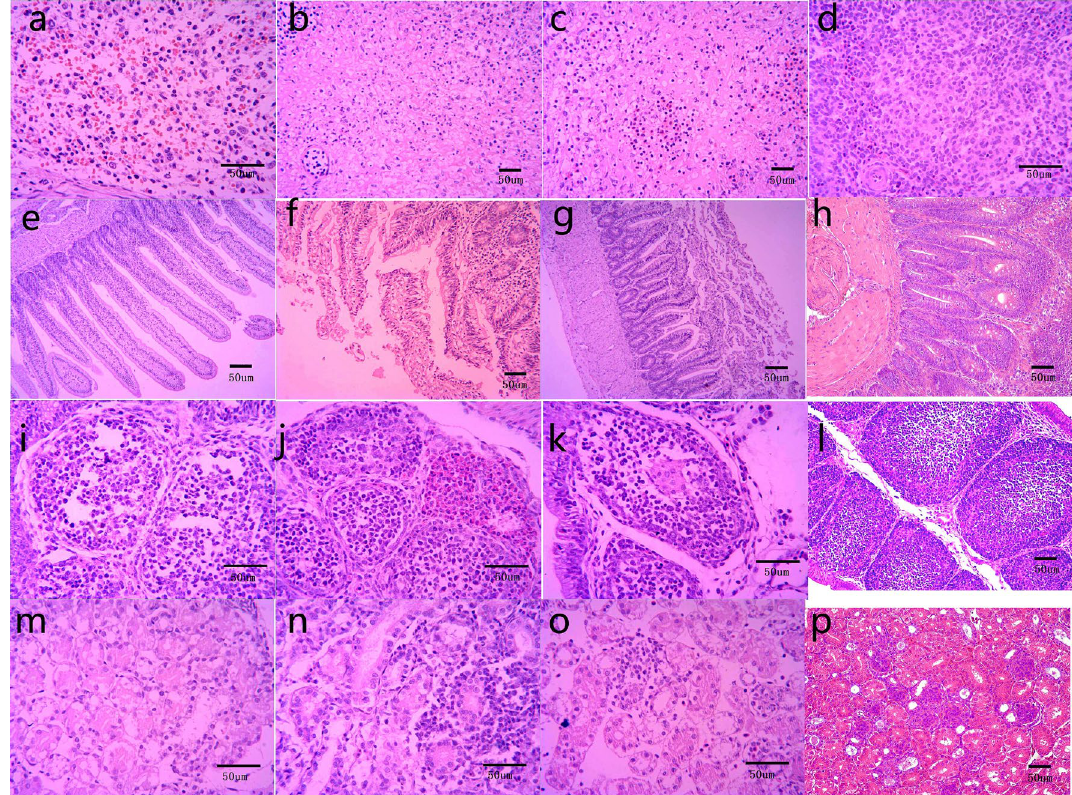
Figure 5. Microscopic pathological changes in spleen, duodenum, bursa and kidney of chickens infected with NDRV by the s.c. route. ( a ) Spleen, 3 dpi: severe lymphocyte depletion, haemorrhage and necrosis; ( b ) Spleen, 6 dpi: many splenic lymphocyte nuclei became pyknotic, and severe focal necrosis was observed; ( c ) Spleen, 9 dpi: moderate lymphocyte necrosis and bleeding; ( d ) Spleen, the control group: no obvious microscopic lesions; ( e ) Duodenum, 3 dpi: no obvious microscopic lesions; ( f ) Duodenum, 6 dpi: detachment of mucosal epithelium at the tip of villi; ( g ) Duodenum, 9 dpi: detachment of mucosal epithelium at the tip of villi.; ( h ) Duodenum, the control group: no obvious microscopic lesions; ( i ) Bursa, 3 dpi: lymphocyte depletion; ( j ) Bursa, 6 dpi: heterophilic granulocytes were increased and infiltrating in the cortex; ( k ) Bursa, 9 dpi: more heterophilic granulocyte infiltrating; ( l ) Bursa, the control group: no obvious microscopic lesions; ( m ) Kidney, 3 dpi: swelling and cytoplasmic granularity in the tubules; ( n ) Kidney, 6 dpi: degeneration and necrosis of tubule cells and interstitial inflammatory cell infiltration; ( o ) Kidney, 9 dpi: more heterophilic granulocytes infiltrating; ( p ) Kidney, the control group: no obvious microscopic